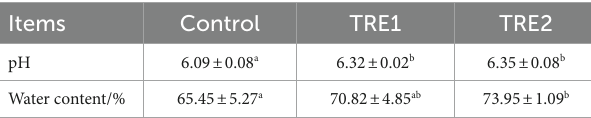
TABLE 3 Effects of feeding bamboo powder on the serum biochemical indexes of sows. Items